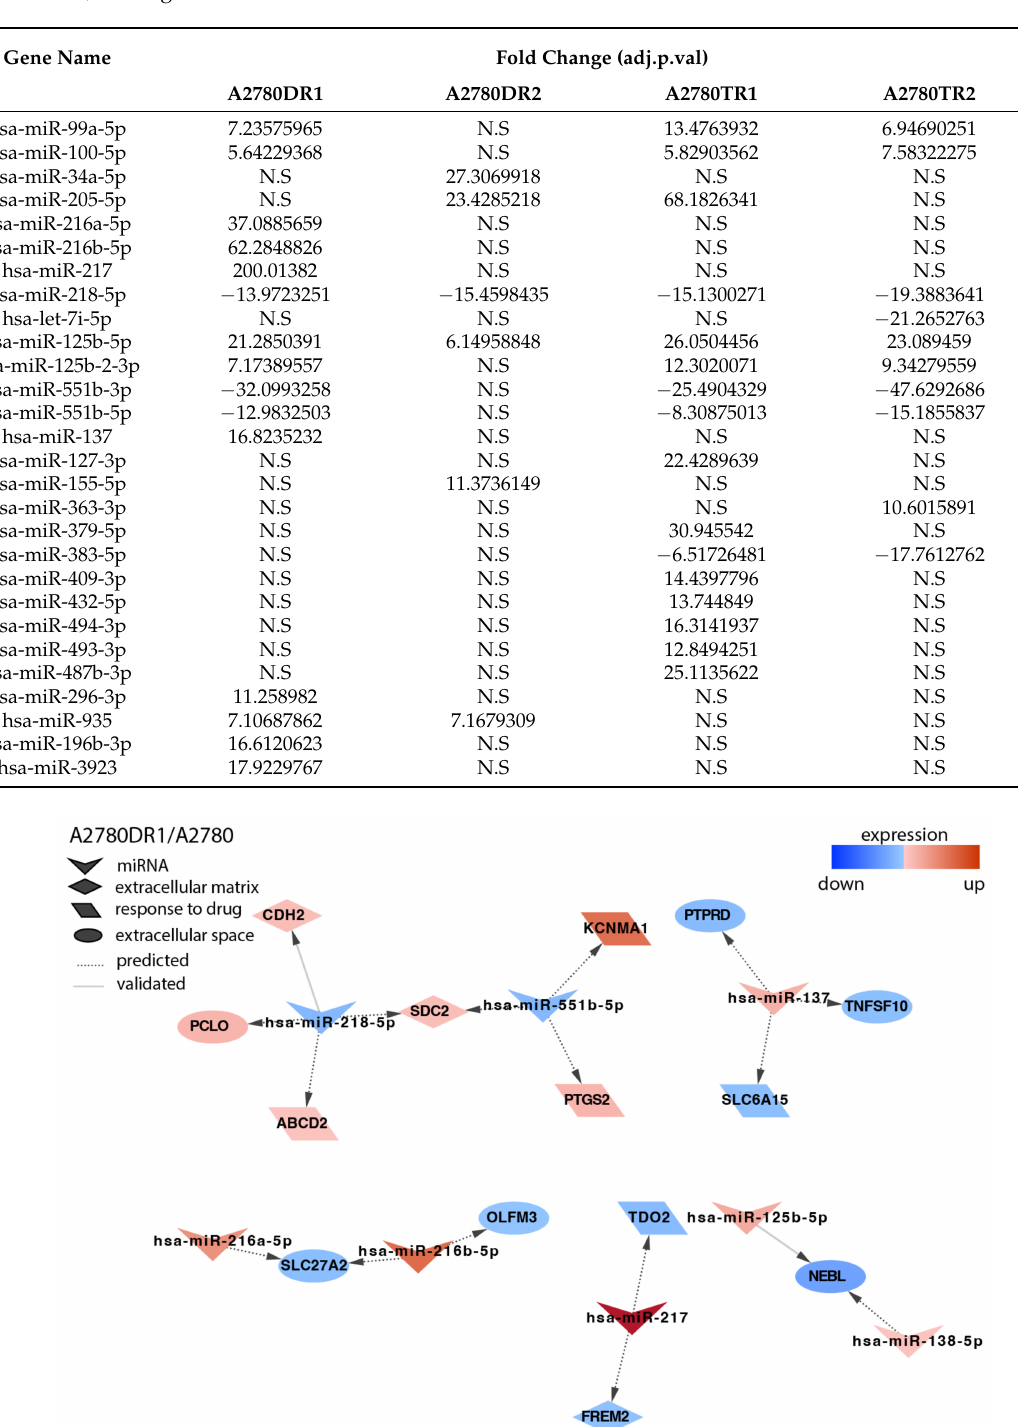
Table 2. List of the miRNA fold changes and false discovery rate (FDR)-corrected p values (adj.p.val.). Each comparison was performed in relation to A2780 cells. N.S: up/downregulation between 5 and − 5, or insignificant alterations.